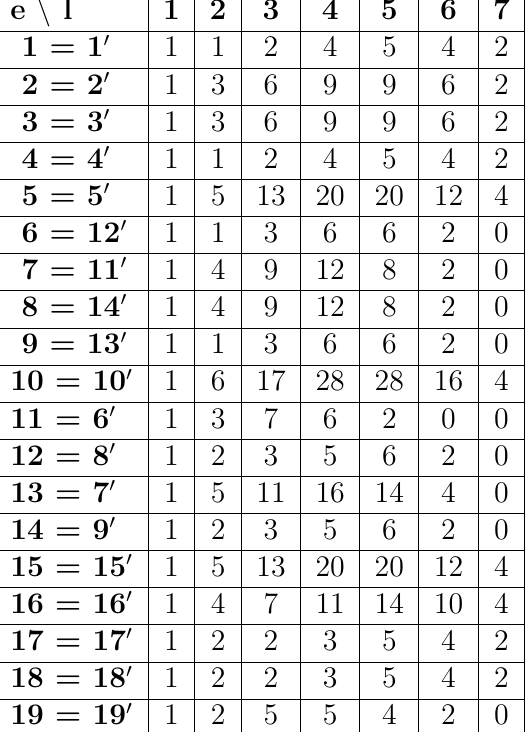
TABLE 5 : The edge path-table for trees 𝑈